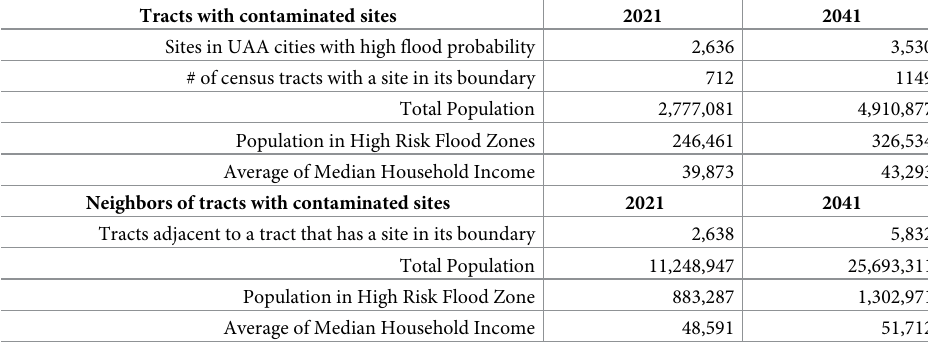
Table 1. Results for analysis of UAA cities, flood risk, and contaminated sites for 2021 and 2041. Tracts with contaminated sites Sites in UAA cities with high flood